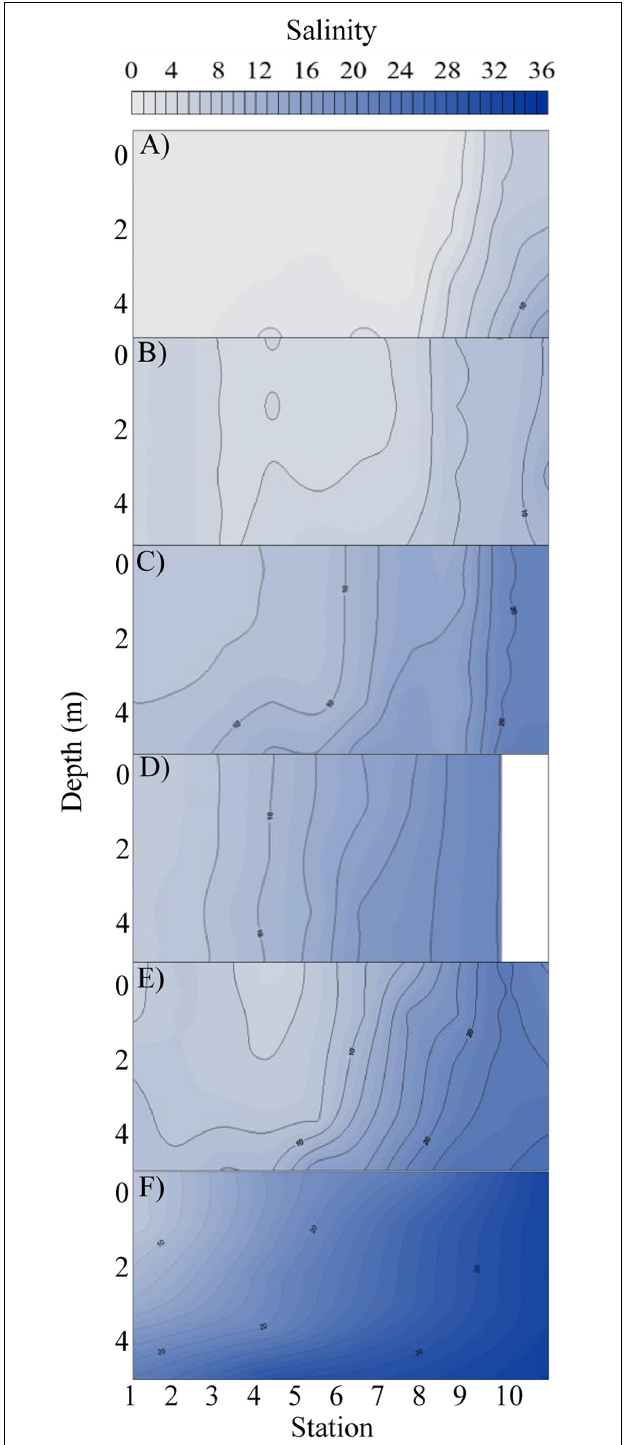
FIGURE 2 | Salinity profile with depth ( y -axis) at each station ( x -axis) along the cruise transect for each time point: (A) T1, (B) T2, (C) T3, (D) T4, (E) T5, and (F) pre-Harvey. The pre-Harvey salinity was measured in the same month (August) during the previous year (2016) along the same sample transect used for this study. Salinities are shown from zero to thirty six along a color gradient from light gray to dark blue,